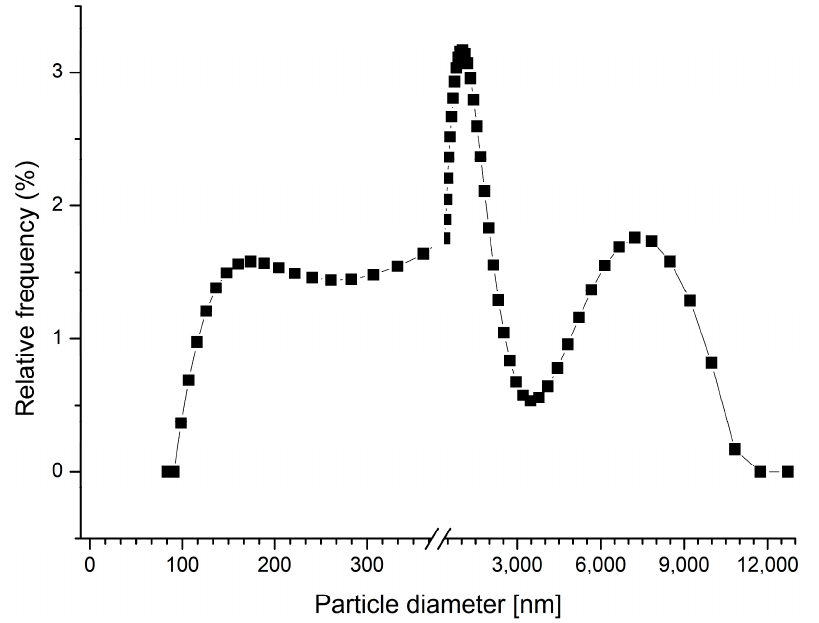
Figure 1. Size distribution of PSS-PAH particles.